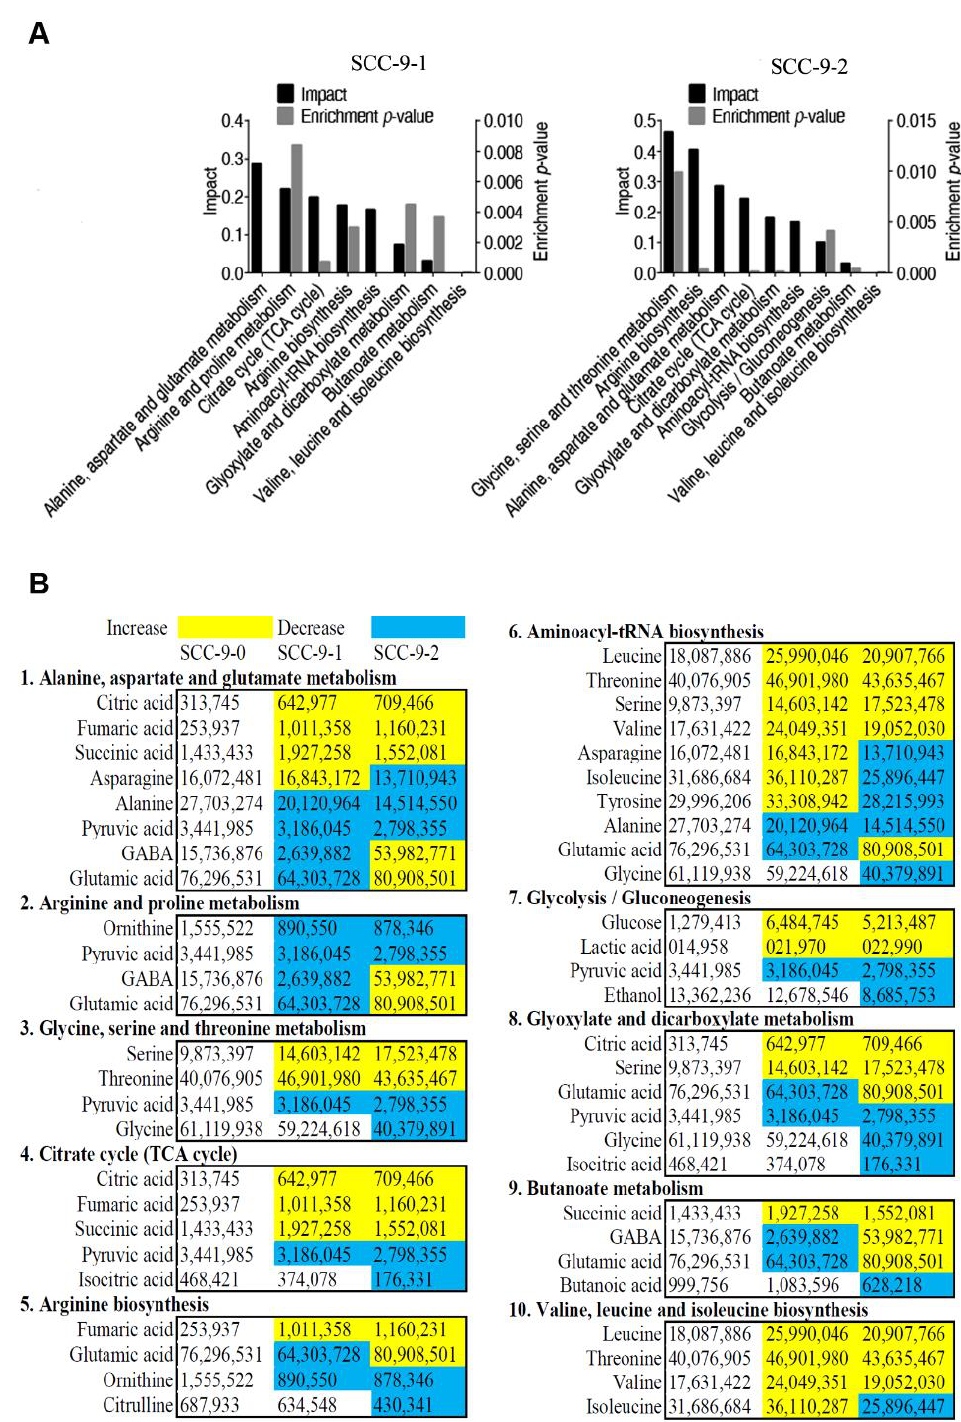
Figure 7 . Pathway enrichment analysis of differential metabolites in HOEC cells after cisplatin treat- Figure 3. Pathway enrichment analysis of differential metabolites in SCC-9 cells treated with cisplatin. Significantly enriched metabolic pathways ( A ). Abundance of metabolites in the enriched metabolic ment. Significantly enriched metabolic pathways ( A ). The abundance of metabolites in the enriched pathways ( B ). SCC9_0, SCC9_1 and SCC9_2 represent the SCC-9 cells treated with cisplatin for 0 h, metabolic pathway ( B ). HOEC_0, HOEC_1 and HOEC_2 represent the HOEC cells treated with cis- 24 h or 48 platin for 0 h, 24 h or 48 h.